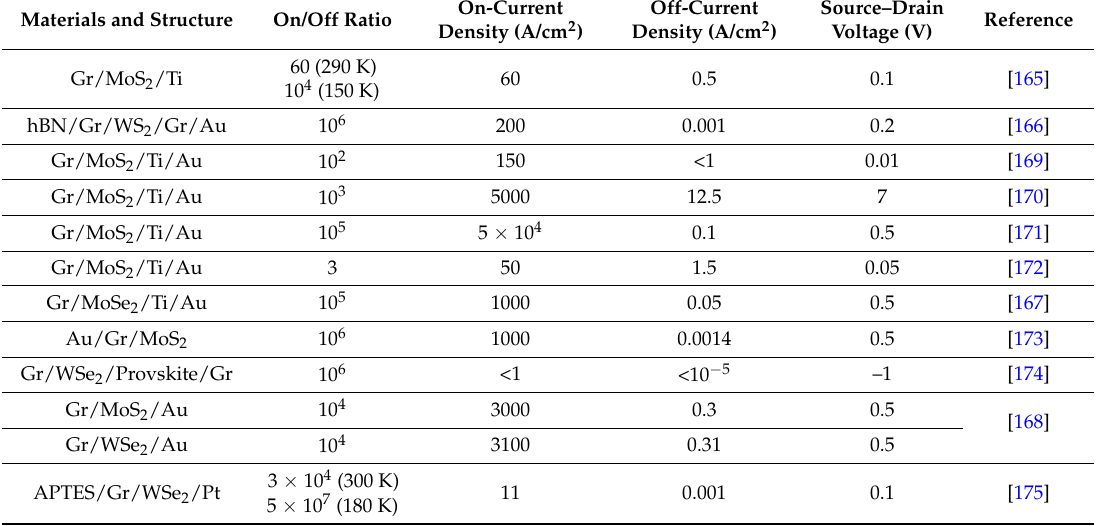
Summary of transistor performances with different vertical heterostructures. Graphene and boron nitride nanosheets are represented as Gr and hBN, respectively. APTES: (3-aminopropyl)